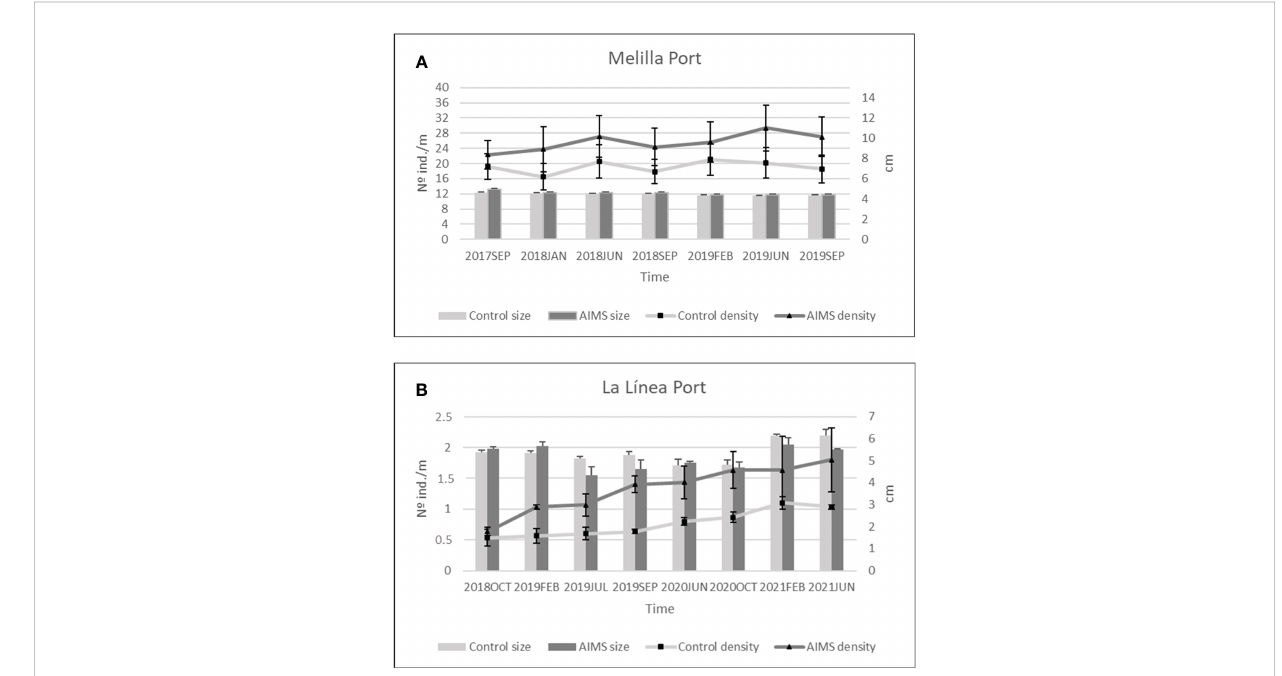
FIGURE 3 Density and size mean values ( ± SE) during the monitoring period in the Control and AIMS transects. (A) : Melilla; (B) : La L ı ́